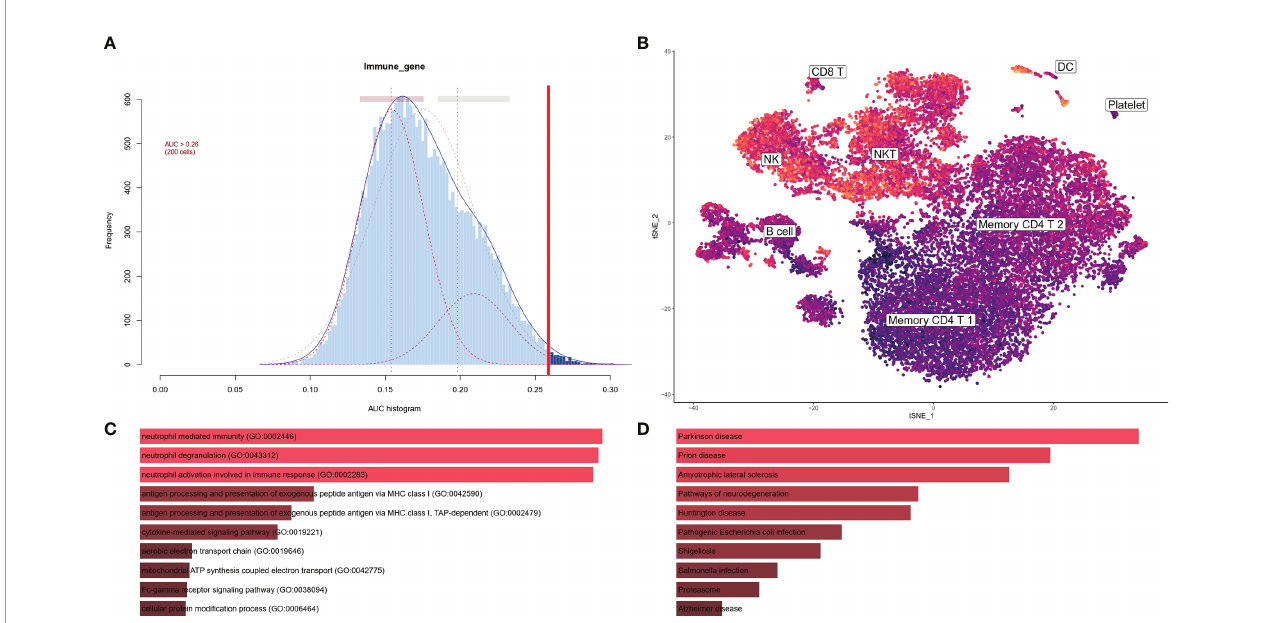
FIGURE 3 | IRG scores of PBMC cell clusters in AD. (A) Score of 212 screened IRGs. The threshold was chosen as 0.26. (B) t-SNE plots of IRG score in all clusters. NK and DC cells express more genes and exhibit higher AUC values. (C) GO analysis of DEGs in NK cluster. The top 10 GOs include neutrophil